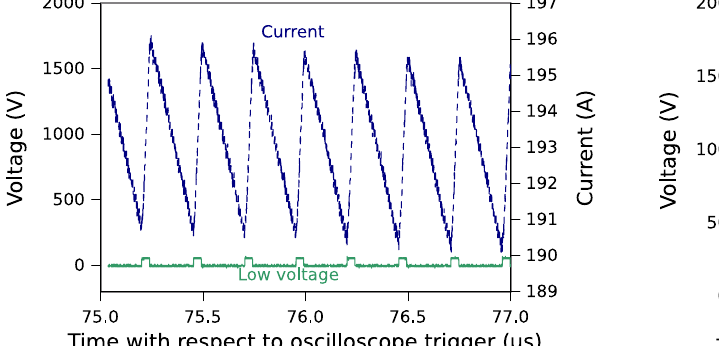
FIG. 17. Measurement with 220 A current, pulsed at 350 Hz with a 1 ms-long flat-top. Dashed blue trace: current. Solid green trace: positive-side output voltage, zoomed in to show the low voltage which maintains the flat-top of the current pulse (de- scribed in the